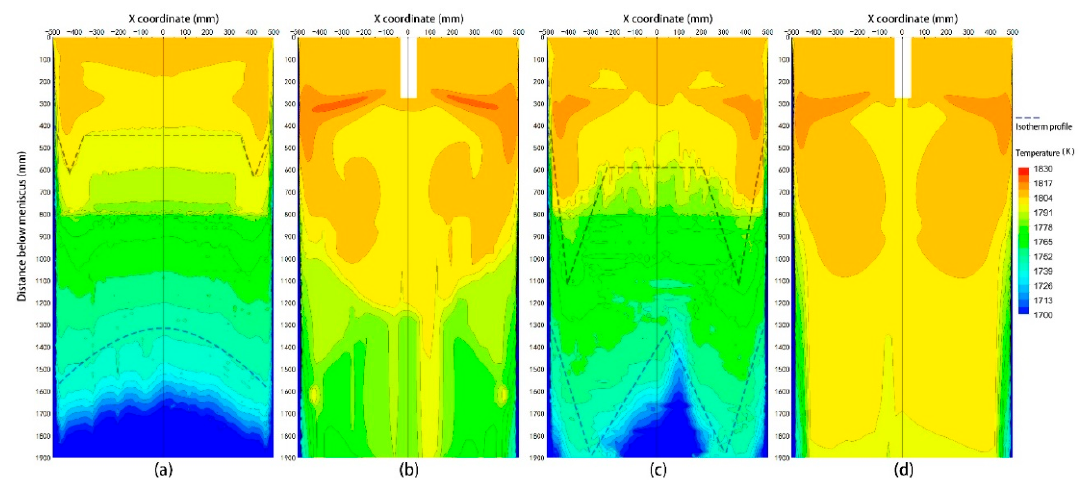
Figure 9. The contour of temperature in different Y plane: ( a ) Y= − 88.875 ( outer arc 1/8); ( b ) Y = − 59.25 ( outer arc 1/4); ( c ) Y= 88.875( inner arc 1/8); ( d ) Y = 59.25 ( inner arc 1/4).